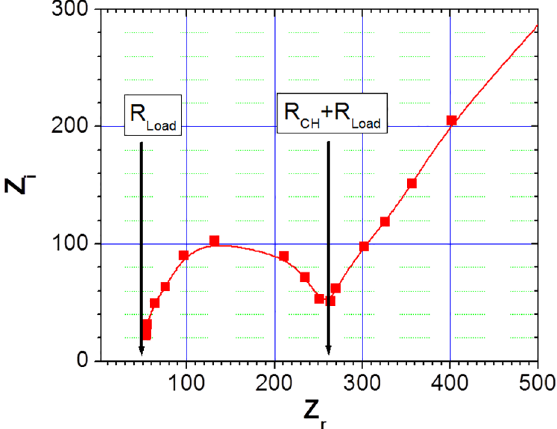
Figure 4. The impedance spectrum of the electrical lysis chamber. An electrical lysis chamber, with dimensions 28 mm(L) 6 6.4 mm(W) 6 0.1 mm(H), was filled with 0.25 mM NaCl solution and its impedance spectrum was recorded in the 2 kHz to 4 MHz frequency range.